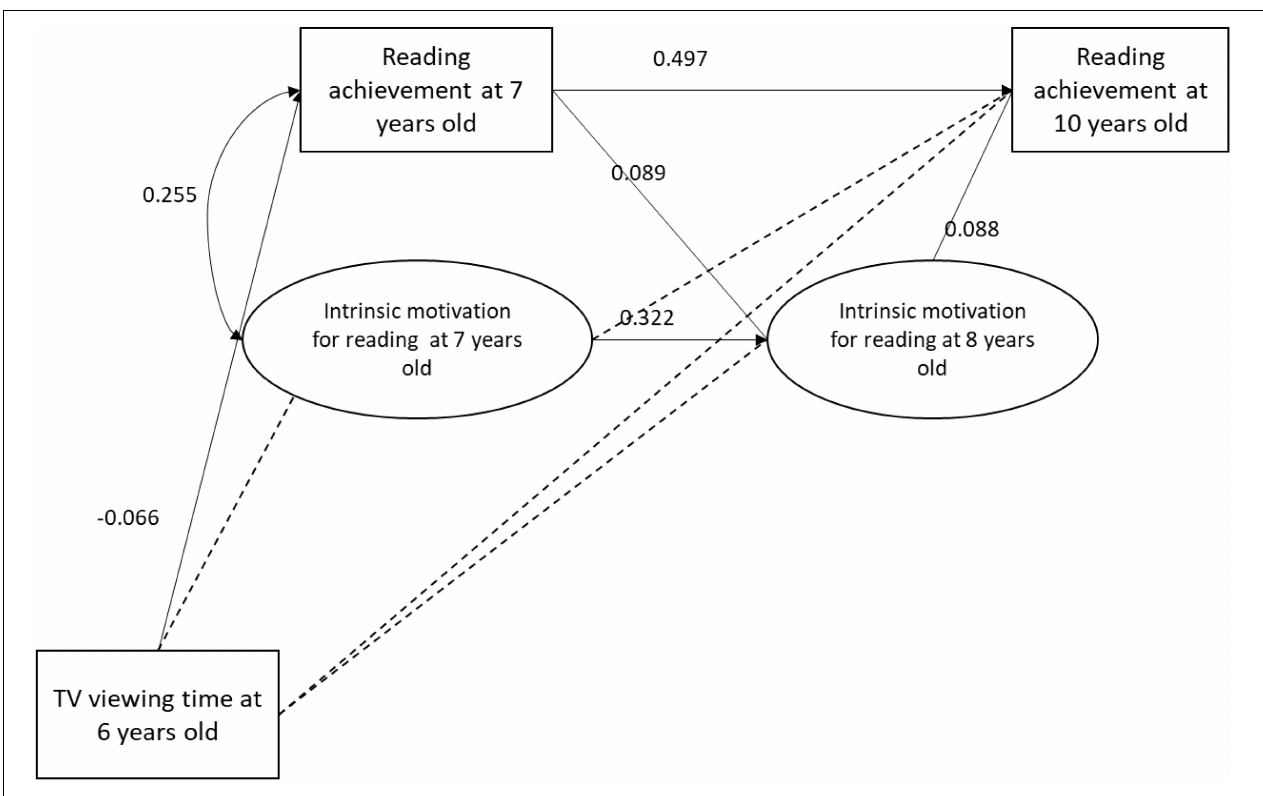
FIGURE 3 | Intrinsic motivation mediation model. Dotted line indicates a p -value above